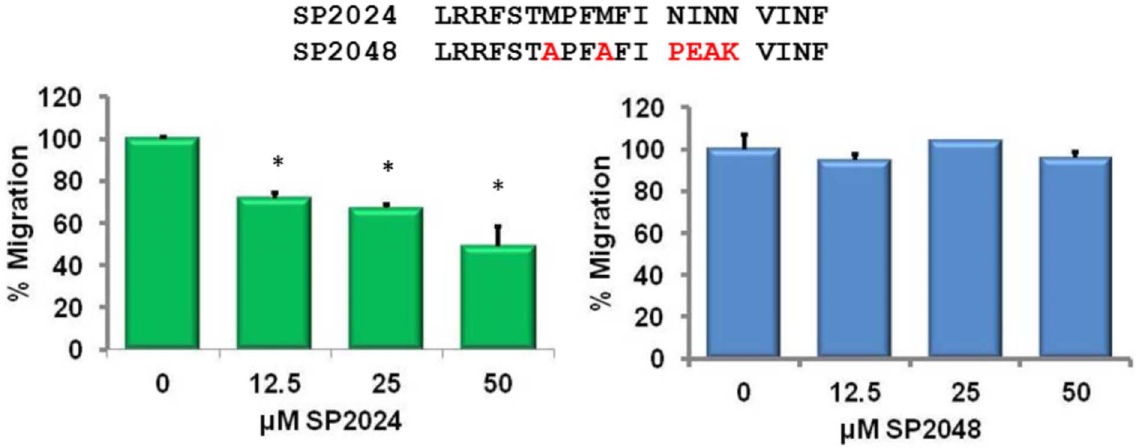
Figure 2. Specific migration inhibition on Microvascular Endothelial Cells (MECs). Inhibition of migration by SP2024 is dose dependent (panel A) while the scrambled peptide SP2048 (panel B) showed no effect on migration irrespective of the treatment dose. Asterisks indicate statistical significance (p , 0.05) in comparison to the control.